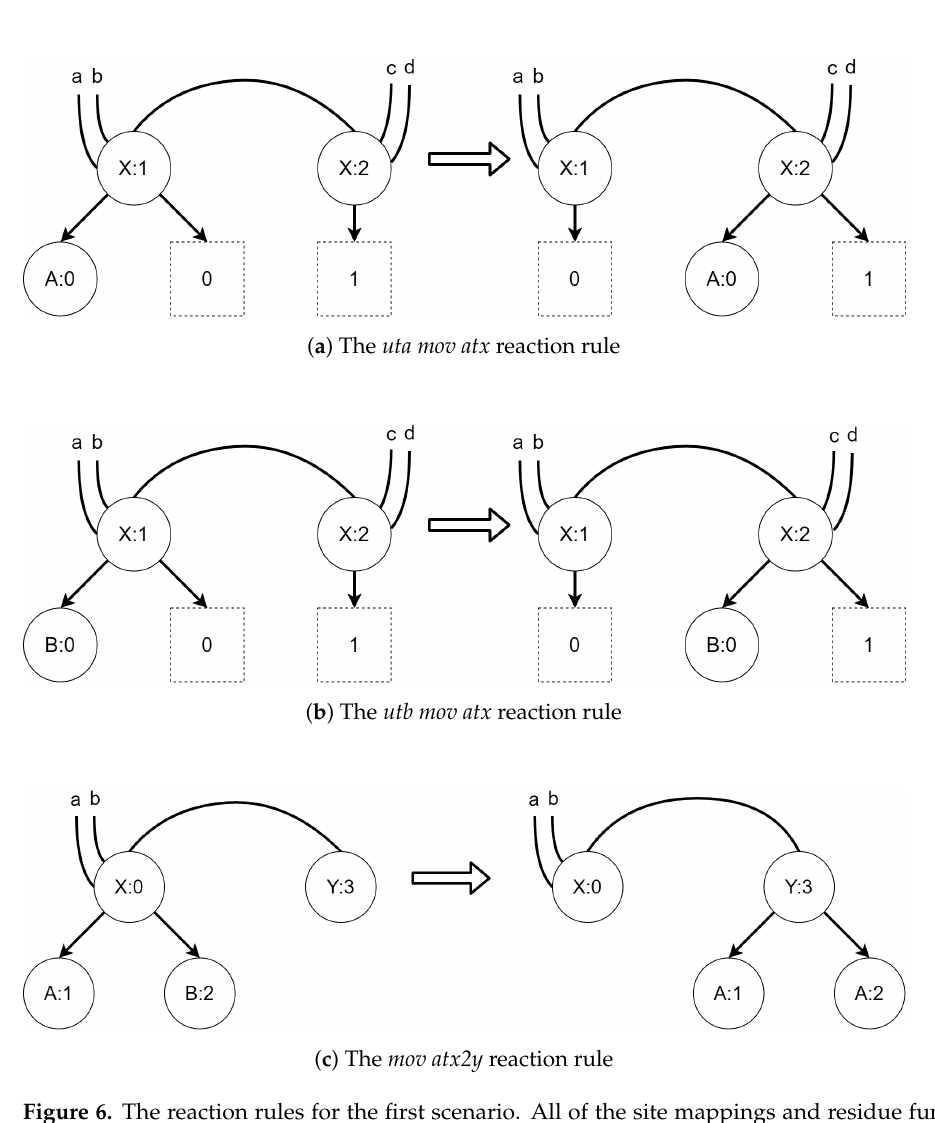
Figure 6. The reaction rules for the first scenario. All of the site mappings and residue functions are